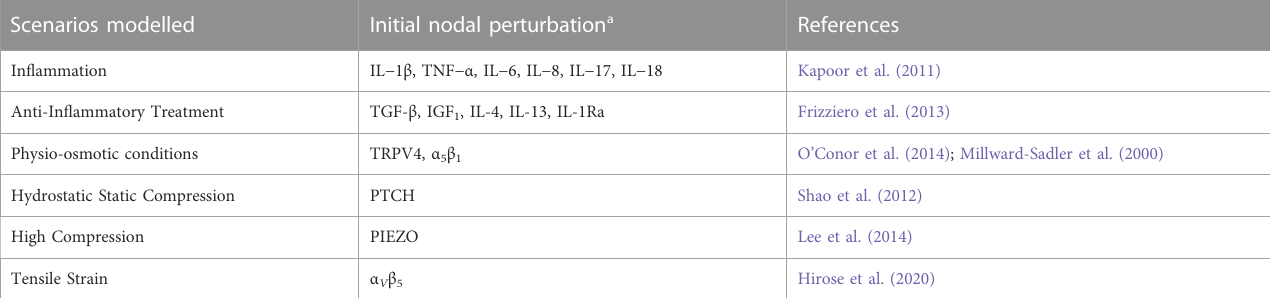
TABLE 1 Initial scenario selection for each mechanical and chemical micro-environment. Scenarios modelled